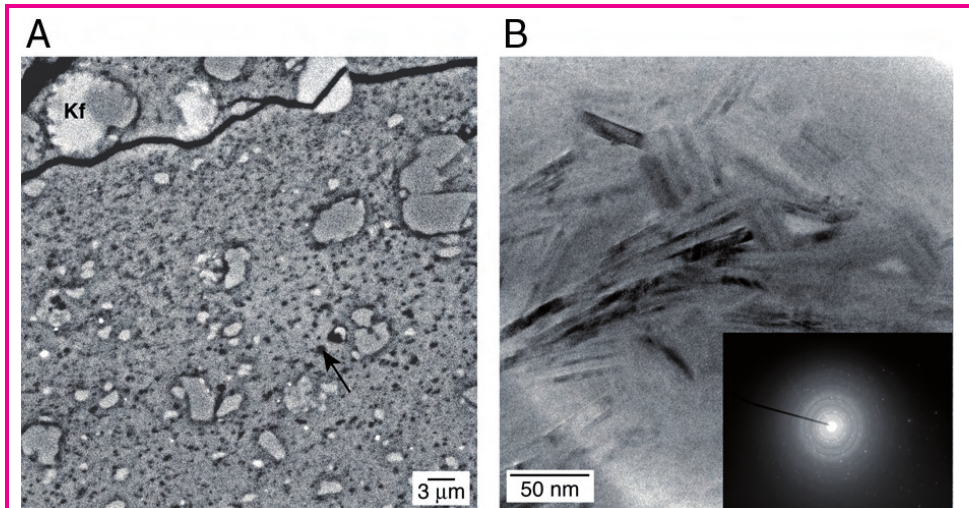
Figure 1. Evidence of frictional melting recorded in the pseudotachylytes. [A] Backscattered electron image of the pseudotachylyte, characterized by vesicles (black arrow) and embayed grains in the homogeneous matrix. Kf: K-feldspar. [B] Transmission electron micrograph of pseudotachylyte (bright-field image). Note the presence of euhedral microcrystals in a glassy matrix. Inset shows the diffraction pattern of the